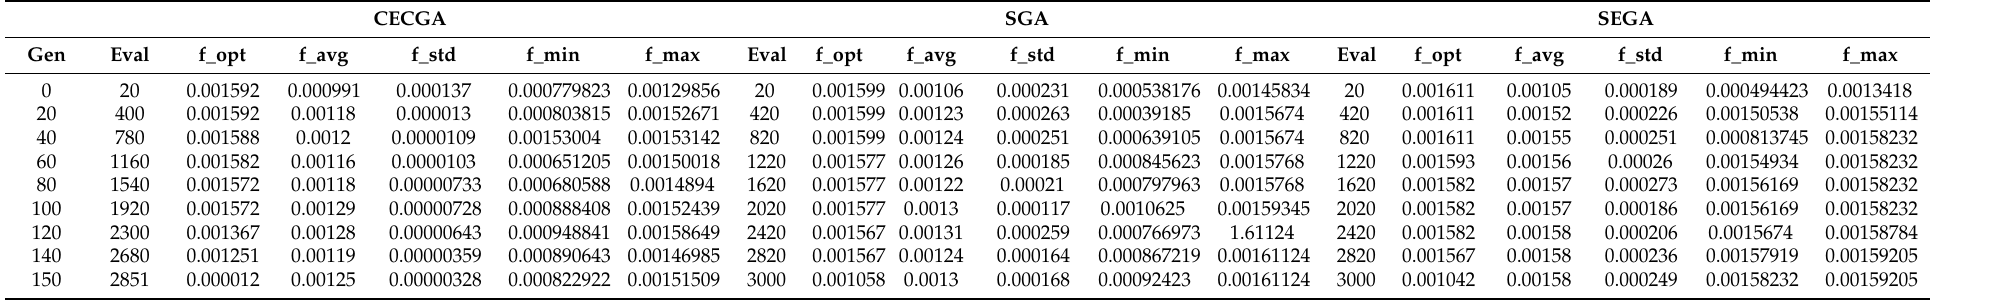
Table 4. The solution results from three algorithms under different